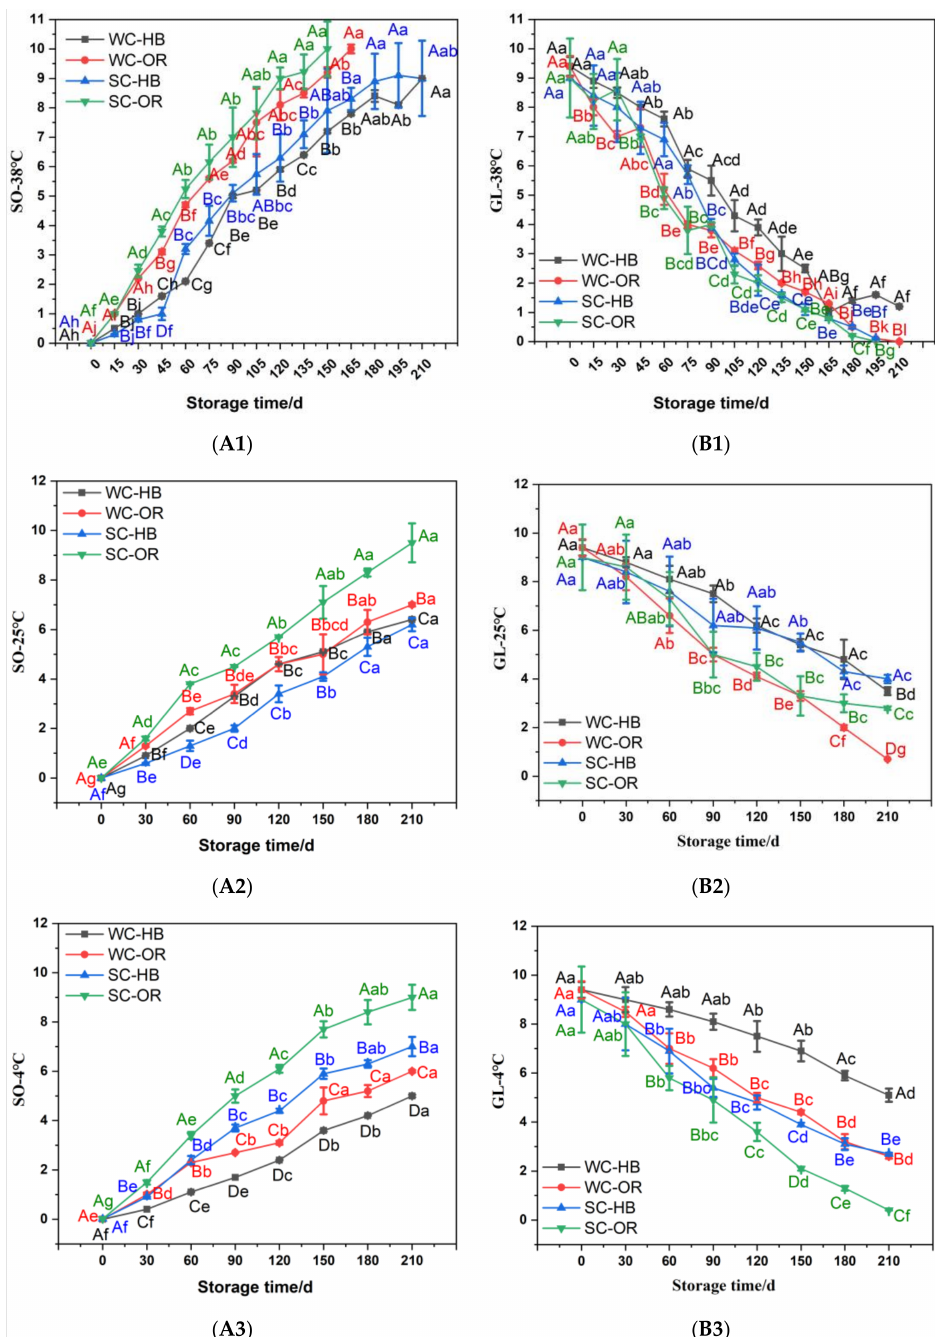
Figure 2. The SO ( A1 – A3 ) and GL ( B1 – B3 ) of fresh corn packaged with HB and OR composite films at three storage temperatures from 0 to 210 d. Different capital letters (A–D) indicate significant differences ( p < 0.05) between different treatments at the same storage time. Different lowercase letters (a–j) indicate significant differences ( p < 0.05) between different storage times for the same treatment. Duncan’s test was used to analyze differences between groups. WC-HB indicates waxy corn packaged with high-barrier nylon/nylon/PP composite film. WC-OR indicates waxy corn packaged with ordinary nylon/nylon/PP composite film. SC-HB indicates sweet corn packaged with high-barrier nylon/nylon/PP composite film. SC-OR indicates sweet corn packaged with ordinary nylon/nylon/PP composite film. SO ( A1 – A3 ) and GL ( B1 – B3 ) indicate the characteristic sensory qualities of sourness and glossiness,